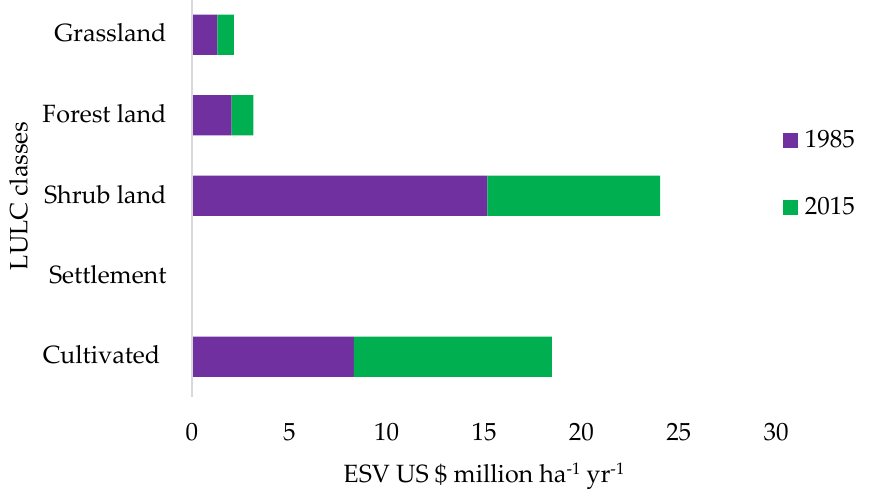
Figure 10. ESV changes from 1985 to 2015 in Andassa watershed, Ethiopia (Source of data: Gashaw et al. [9], but figure done by authors).